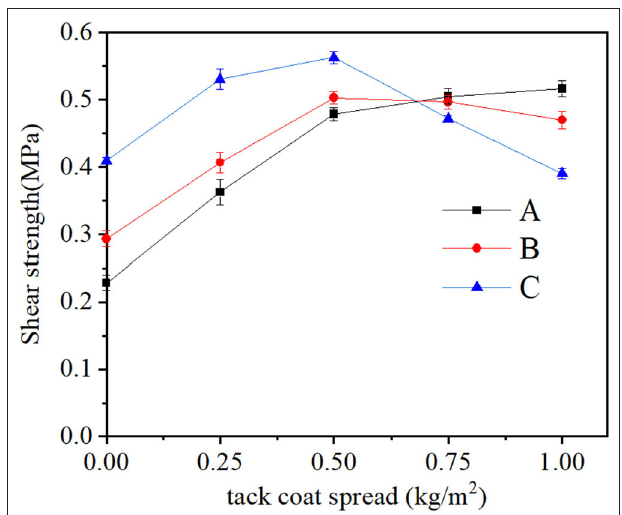
FIGURE 9 | Interfacial shear strength at different tack coat spreading